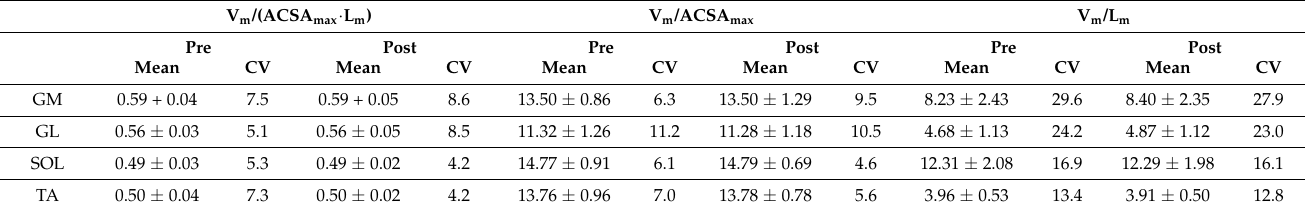
Table 3. Mean values ± SDs and the coefficient of variance (in %) of the ratio between V m and the product of ACSA max and L m , the ratio between V m and ACSA max , and the ratio between V m and L m for the GM, GL, SOL and TA